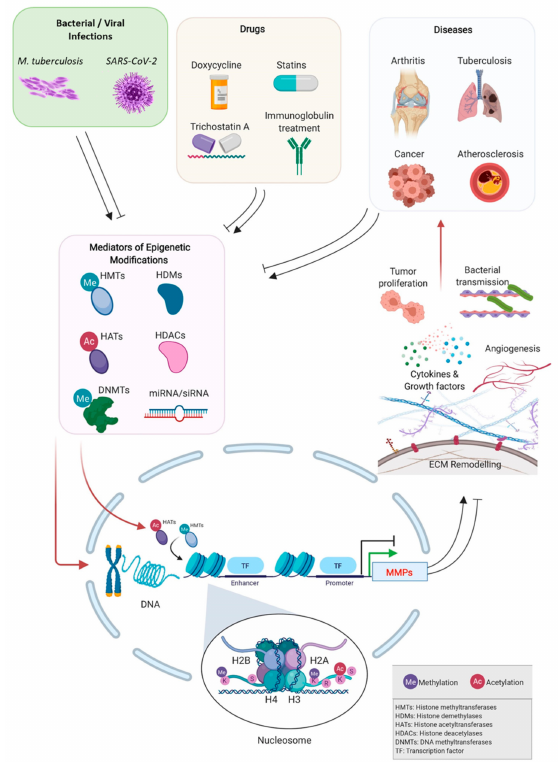
Figure 1. A summary map of the epigenetic regulation of matrix metalloproteinases (MMPs). The epigenetic pressure inducers affecting MMP genes include (i) pathological mechanisms underlying chronic diseases, and (ii) drugs commonly used in treatments for chronic diseases. Epigenetic modifications on DNA, histones, and expression of miRNAs result in dysregulation of the gene expression of MMP, which leads to (i) further promotion of the pathogenesis of an existing disease, and (ii) initiating abnormal remodeling of the extracellular matrix and the regulation of other MMP